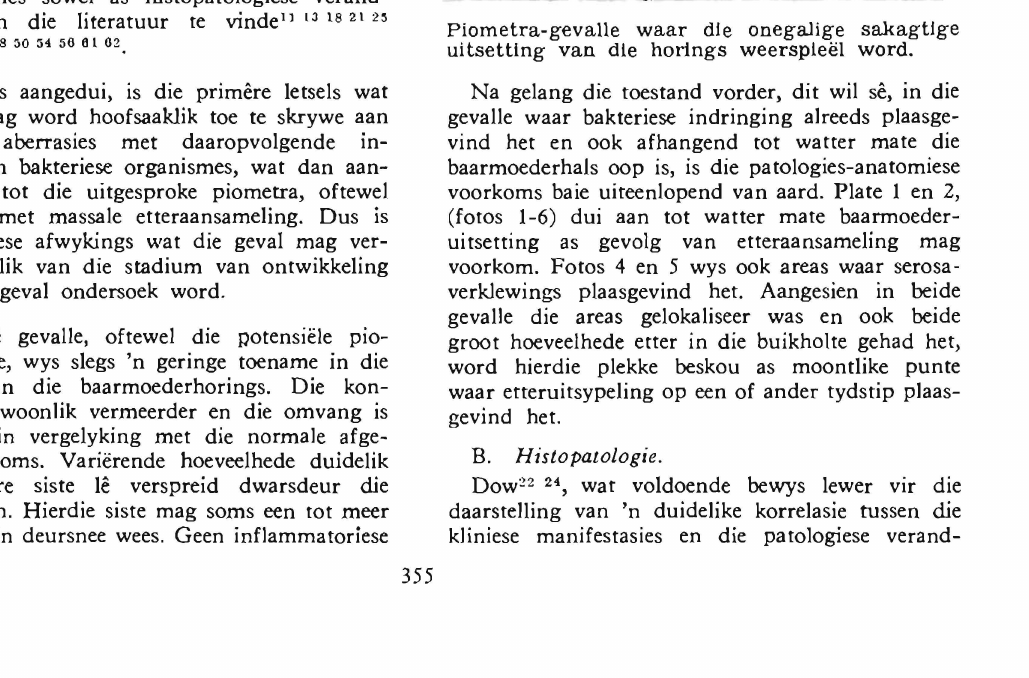
Volledige beskrywingspunte aangaande die pato logiesanatomies sowel as histopatologiese verand